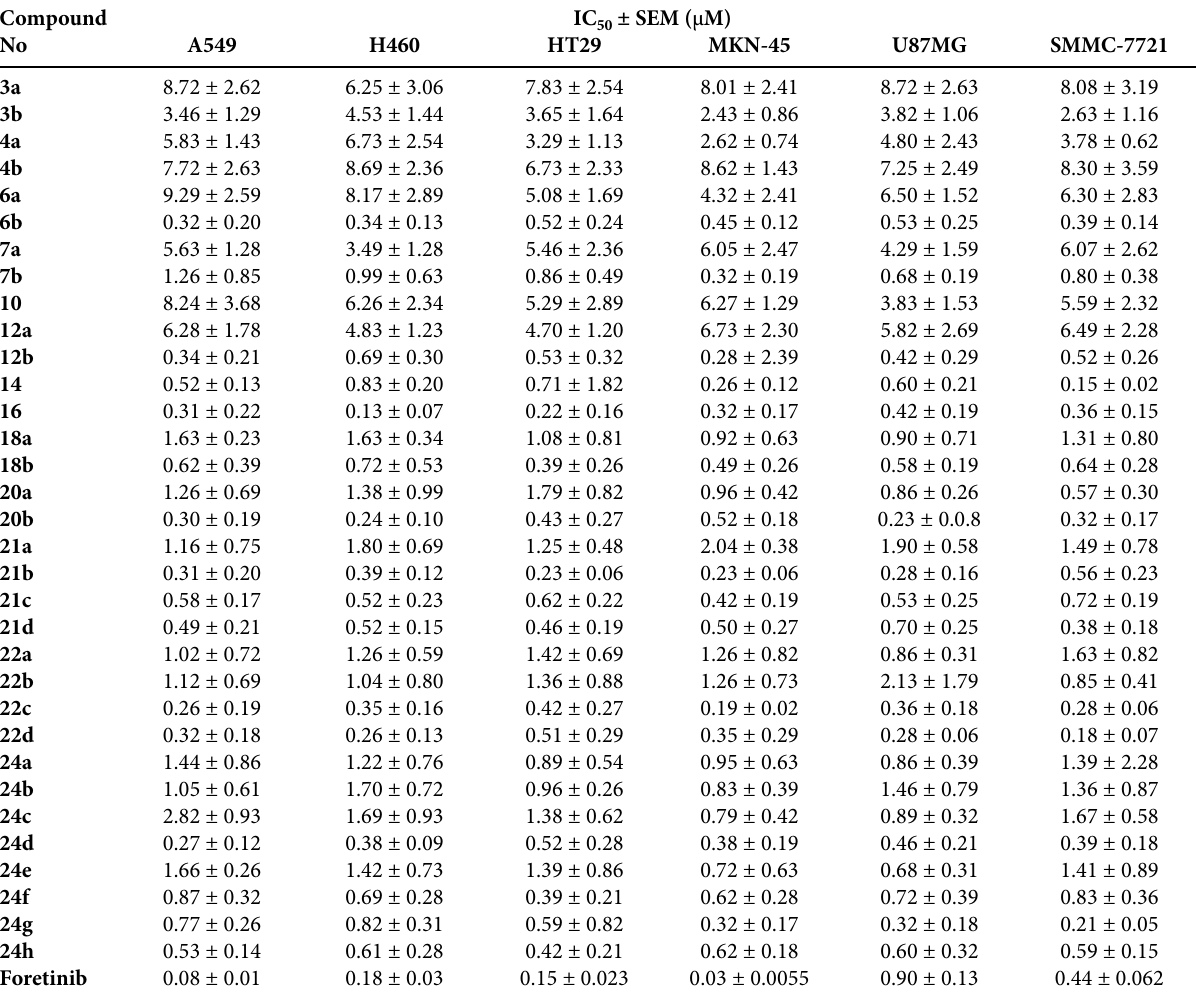
Table 1 . In vitro growth inhibitory effects IC 50 ± SEM ( µ M) of the newly synthesized compounds against cancer cell